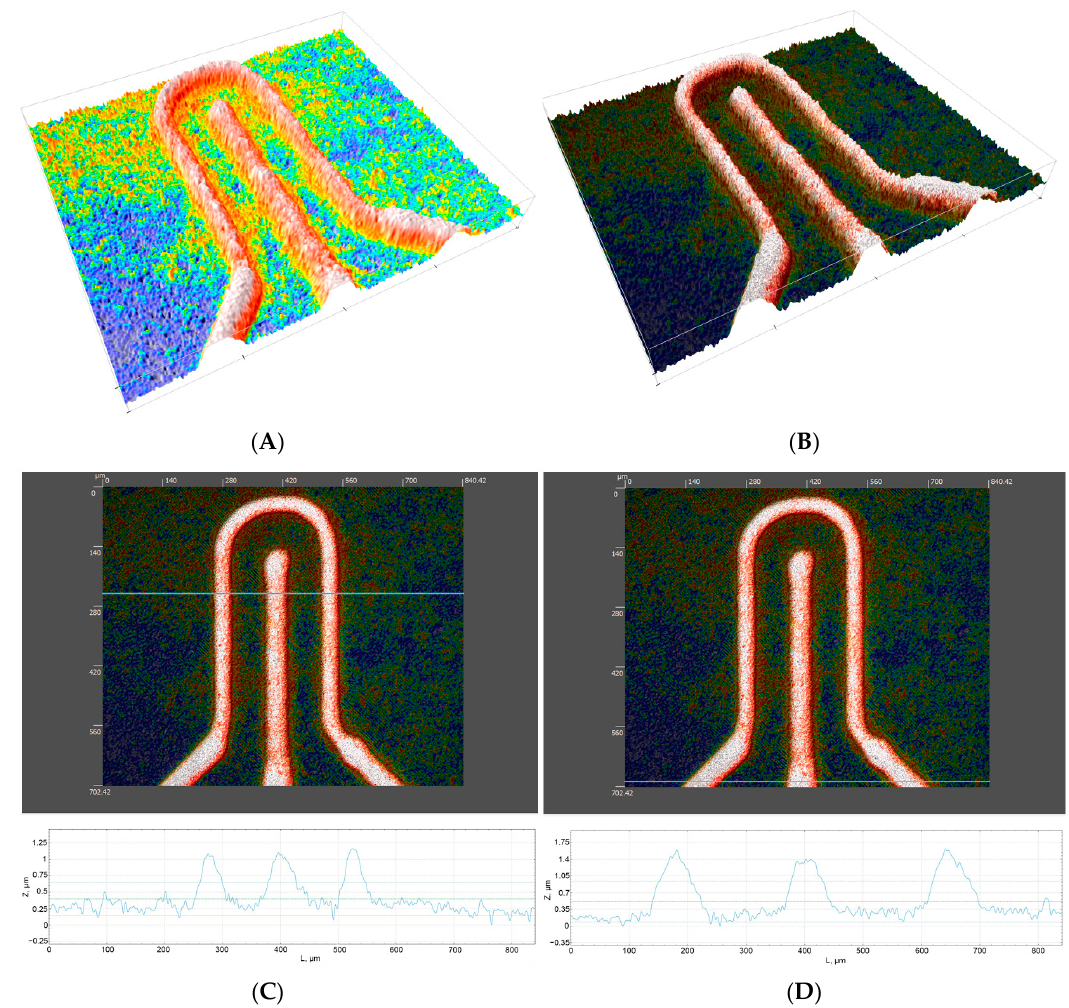
Figure 12. Images of a typical microheater annealed at 750 °C, which were rendered based on data acquired with a non-contact optical 3D profiler. ( A , B ) Perspective view in two color schemes. ( C ) Top view and profile of the narrowest part of the microheater. ( D ) Top view and profile of the initial part of the arms adjacent to the narrowest part. The presented profiles correspond to the positions of the light blue lines.